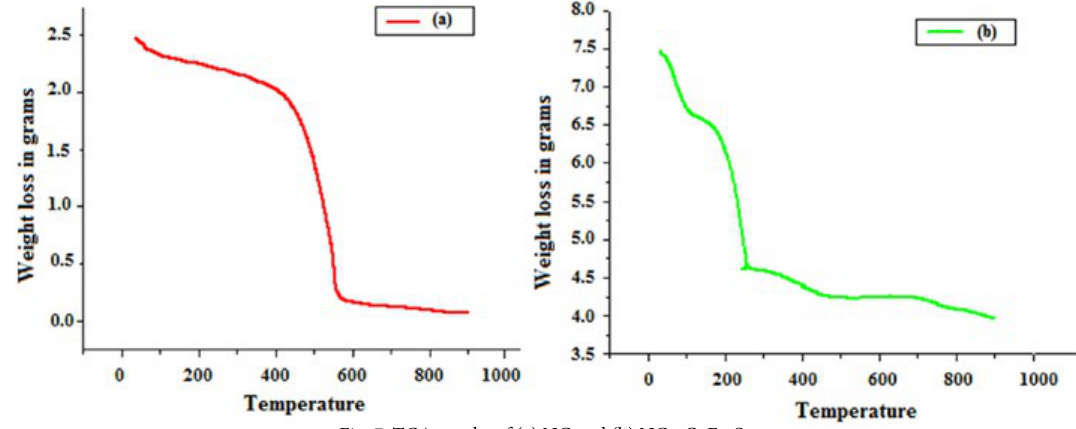
Fig. 7: TGA graphs of (a) NG and (b) NG@CoFe Fig. 7 TGA graphs of (a) NG, and (b) NG@CoFe 2 O 4